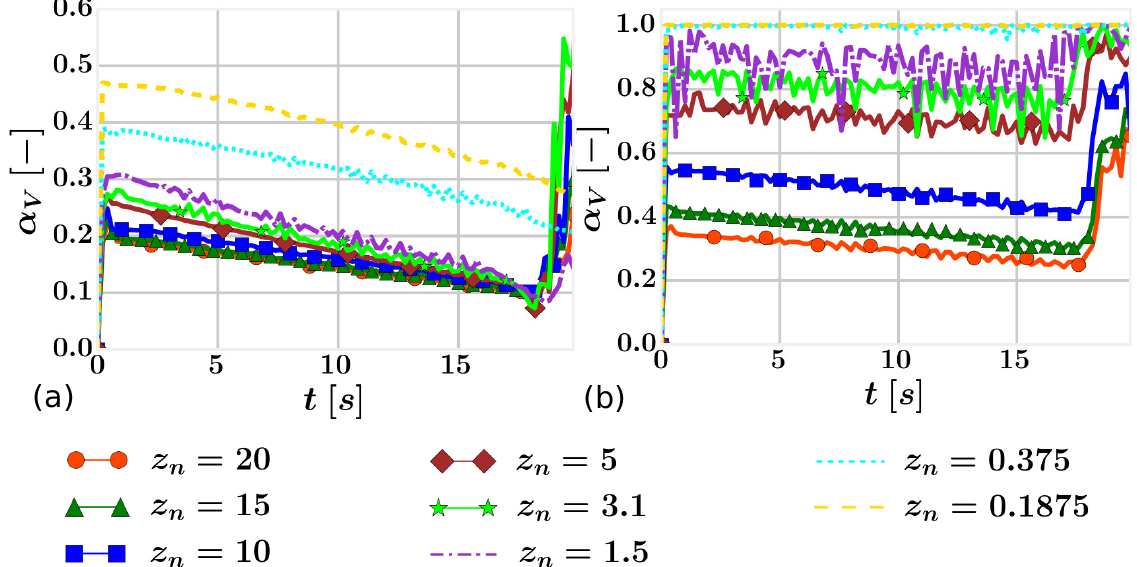
Figure 4. Cooling curves acquired at the location L 2 in the solid region using various fluid meshes. The interfacial phase change is not activated. ( a ) Global view with validation data; ( b ) Focused view to a time range 17–19.8 s omitting results for z n = 15; 5; 0.375; 0.1875, and the experimental results.